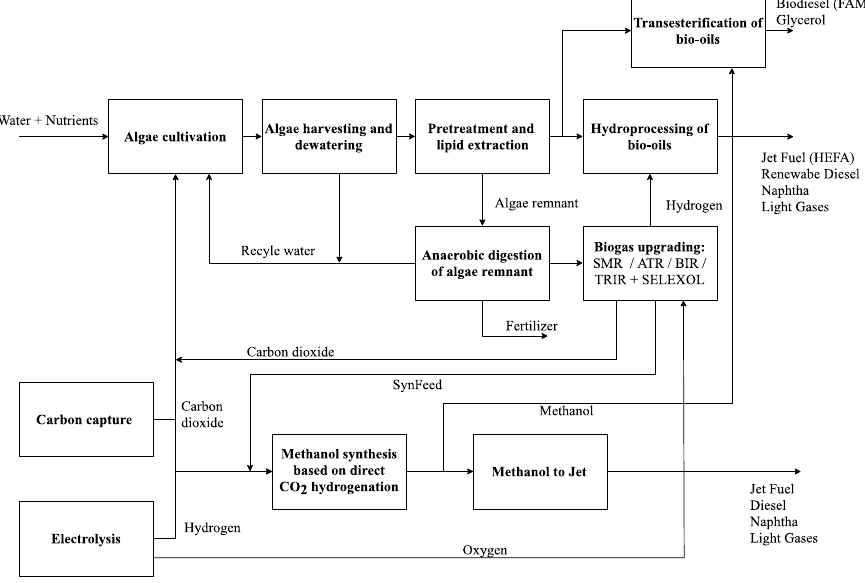
Figure 1. Concept of an integrated algae biorefinery.